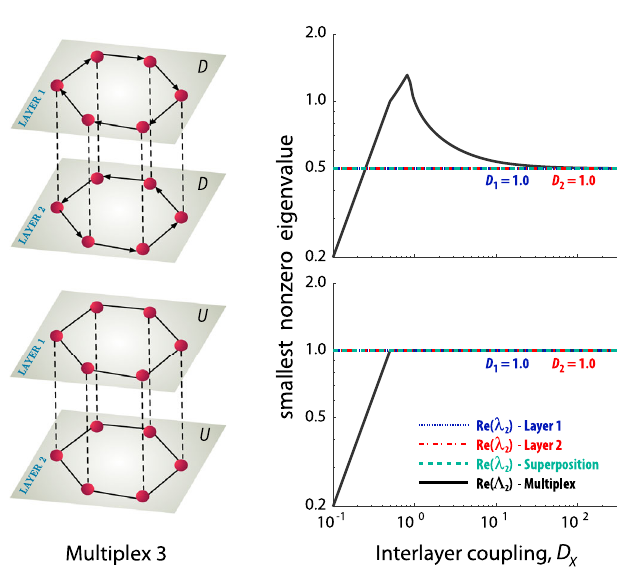
FIG. 10. Characteristic rate of convergence to stationary state solution of a continuous-time Markov chain on multiplex 3 and its undirected